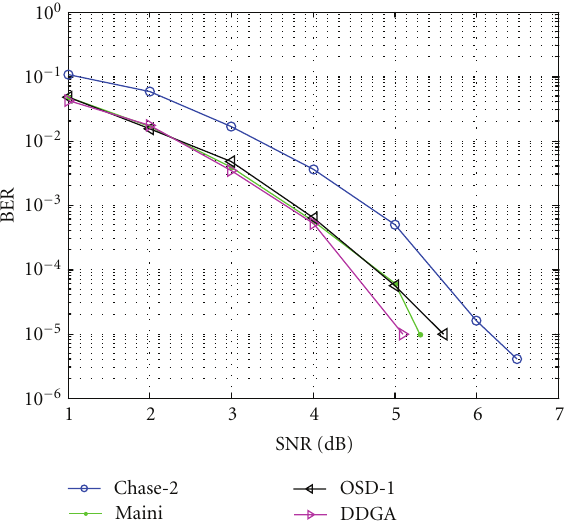
Figure 11: Performances of Chase-2, Maini, OSD-1, and DDGA algorithms for BCH (31,16,7) code.